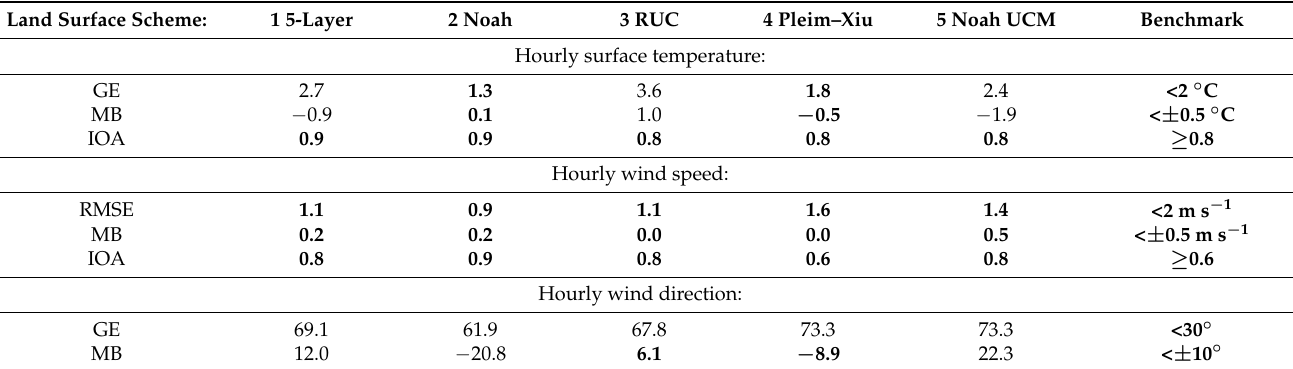
Table 5. Metrics for the meteorological modeling. Bold numbers indicate values in the bench- mark